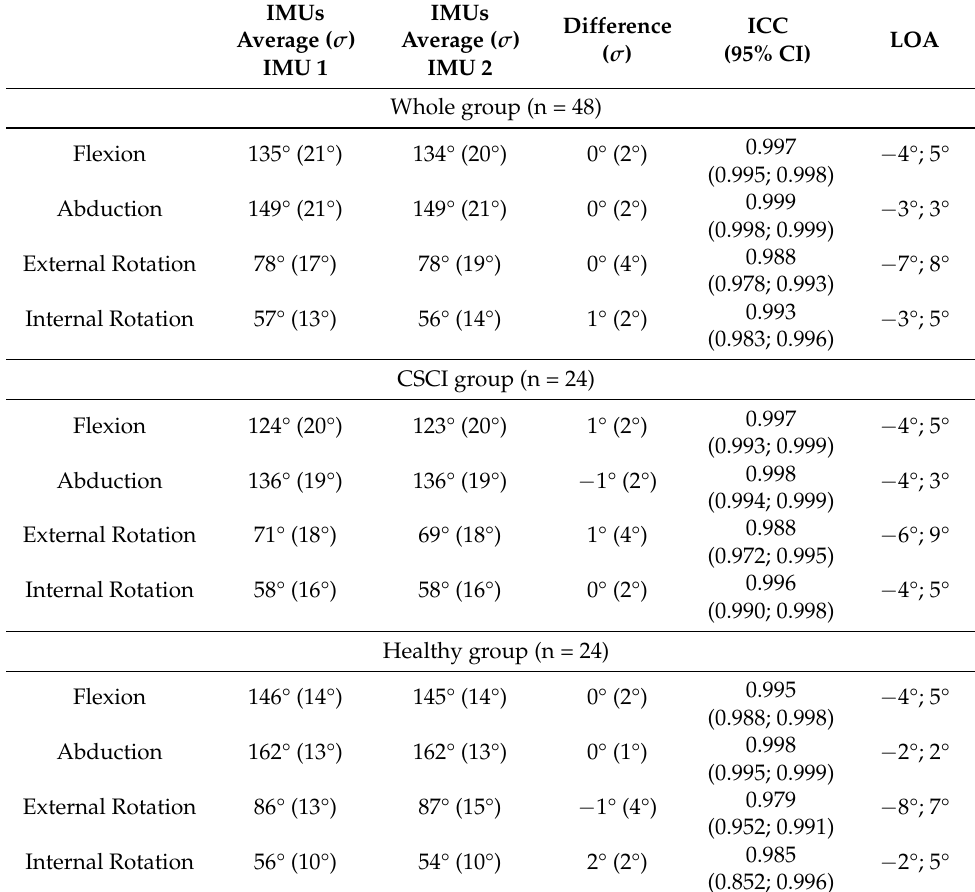
Table 10. Inter-tester/rater reliability indicators for IMU measurements in CSCI patients and healthy group for IMU 1 and IMU